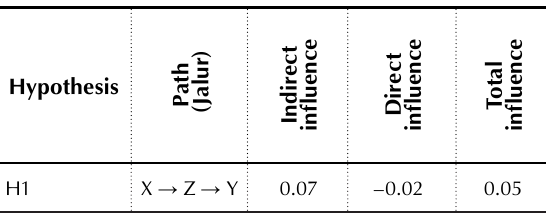
Table 3. Indirect influence testing